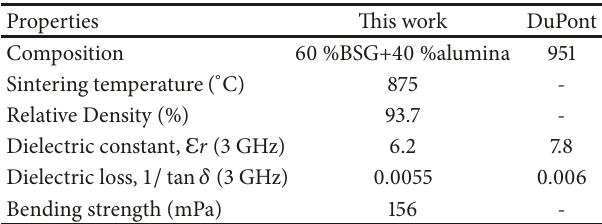
Table 1: Properties of printed glass-ceramic